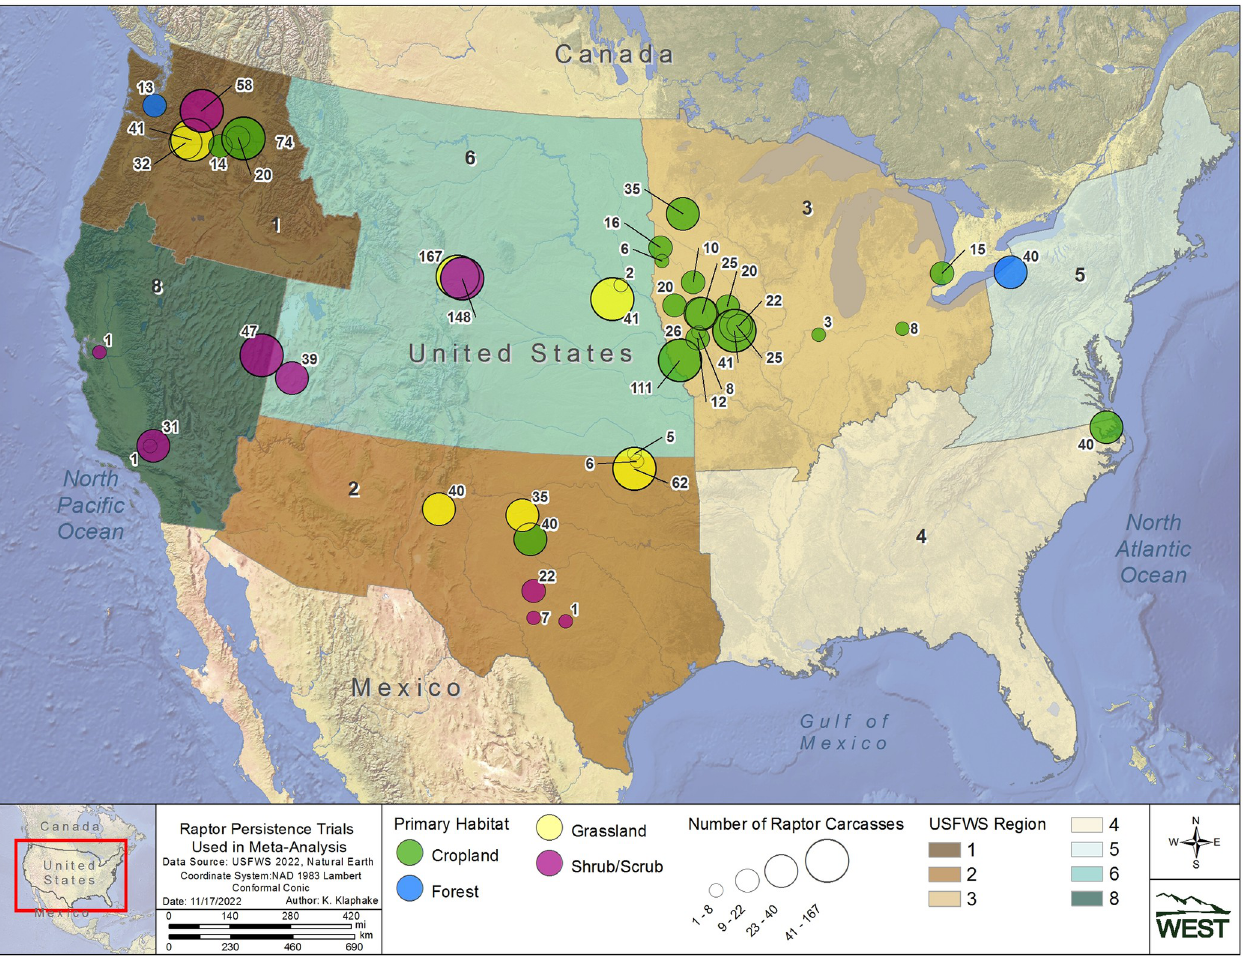
Fig 8. Locations of raptor carcass persistence trials included in the meta-analyses.